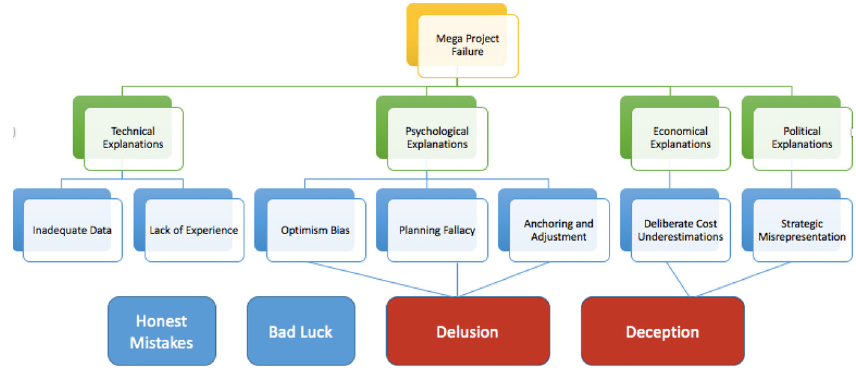
Exhibit 2 Explanations of Megaproject Failure and the Underlying